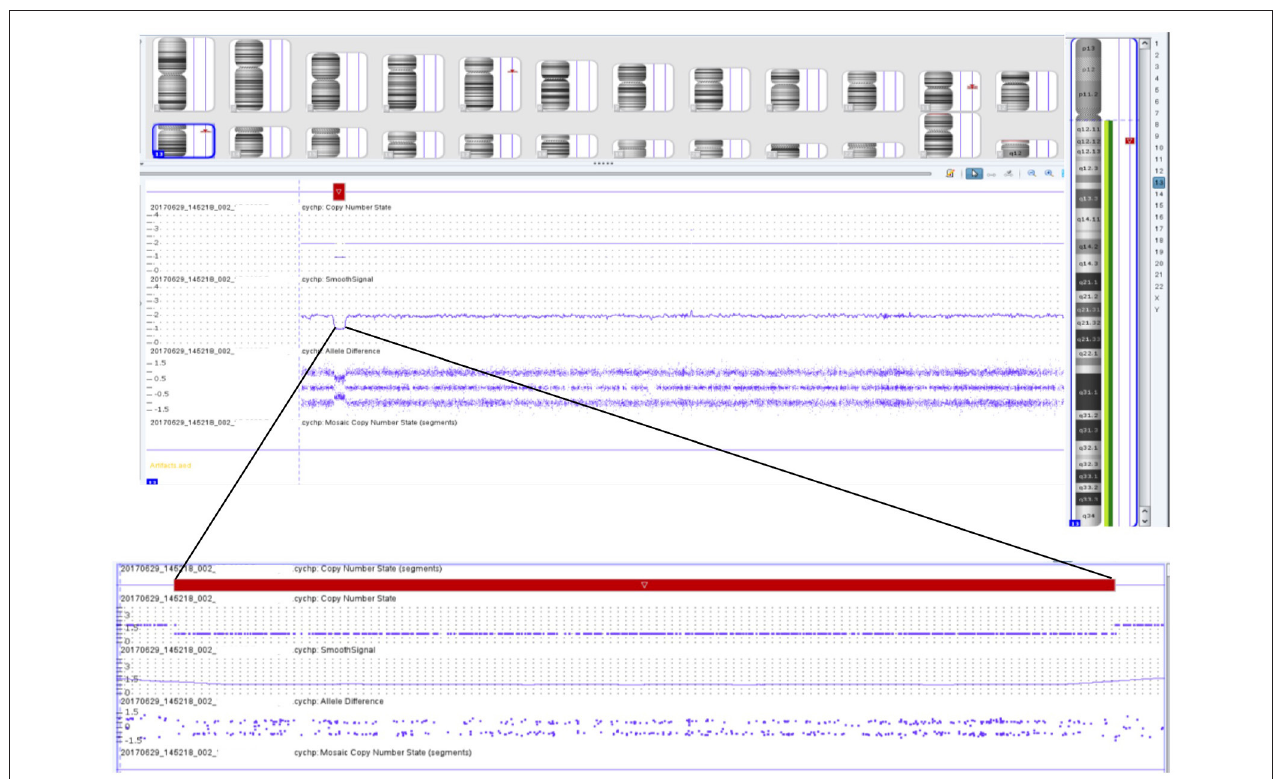
FIGURE 3 | Chromosomal microarray showing 1.422 megabase loss in the 13q12.12 region containing 14 different genes, including the SACS